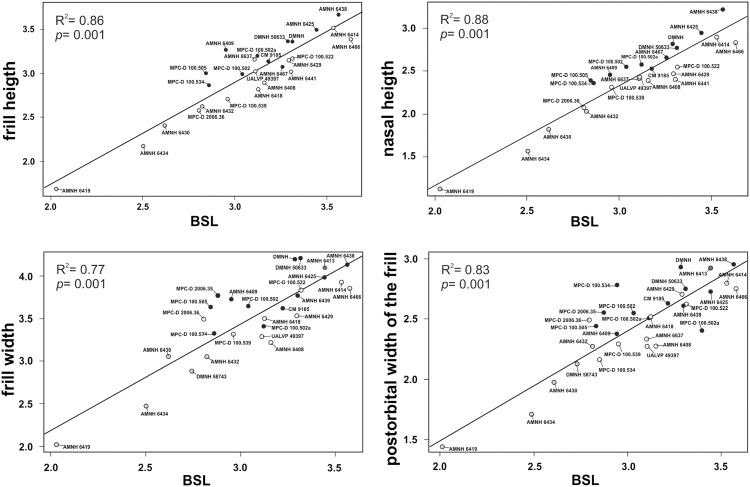
Linear regressions of basal skull length (BSL) against the four sex-discriminant variables of the Protoceratops sample (see Table B in S1 File).Black dot represents “male”, white dot represents “female”, gray dot represents juvenile, and red dot represents a sex-undetermined specimen. Scale of axes is logarithmic.